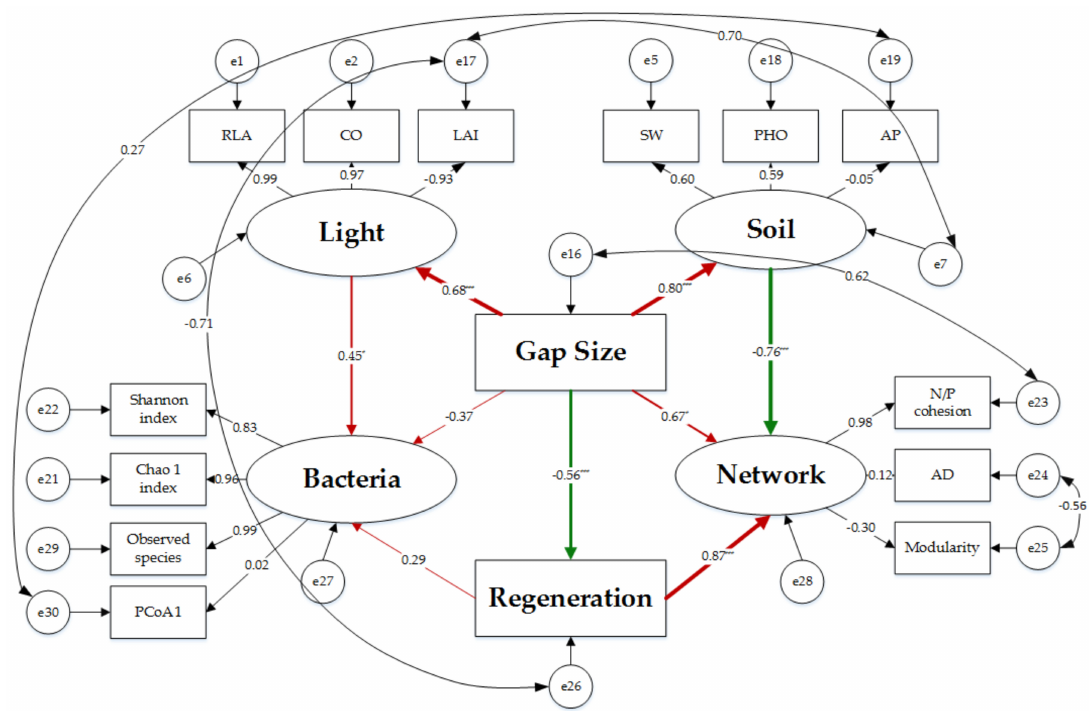
Figure 6. A structural equation model was established to explore the significant effects of gap size; soil physicochemical index (SW, PHO, AP); light properties (RLA, CO, LAI); soil bacteria composition (first axis of principal coordinate analysis, Shannon, observed species richness, and Chao1 indices); network complexity (Modularity, AD, N/P cohesion); and tree regeneration (regeneration density). Significant codes “***” indicate the p value < 0.001, “*” indicates the p value <